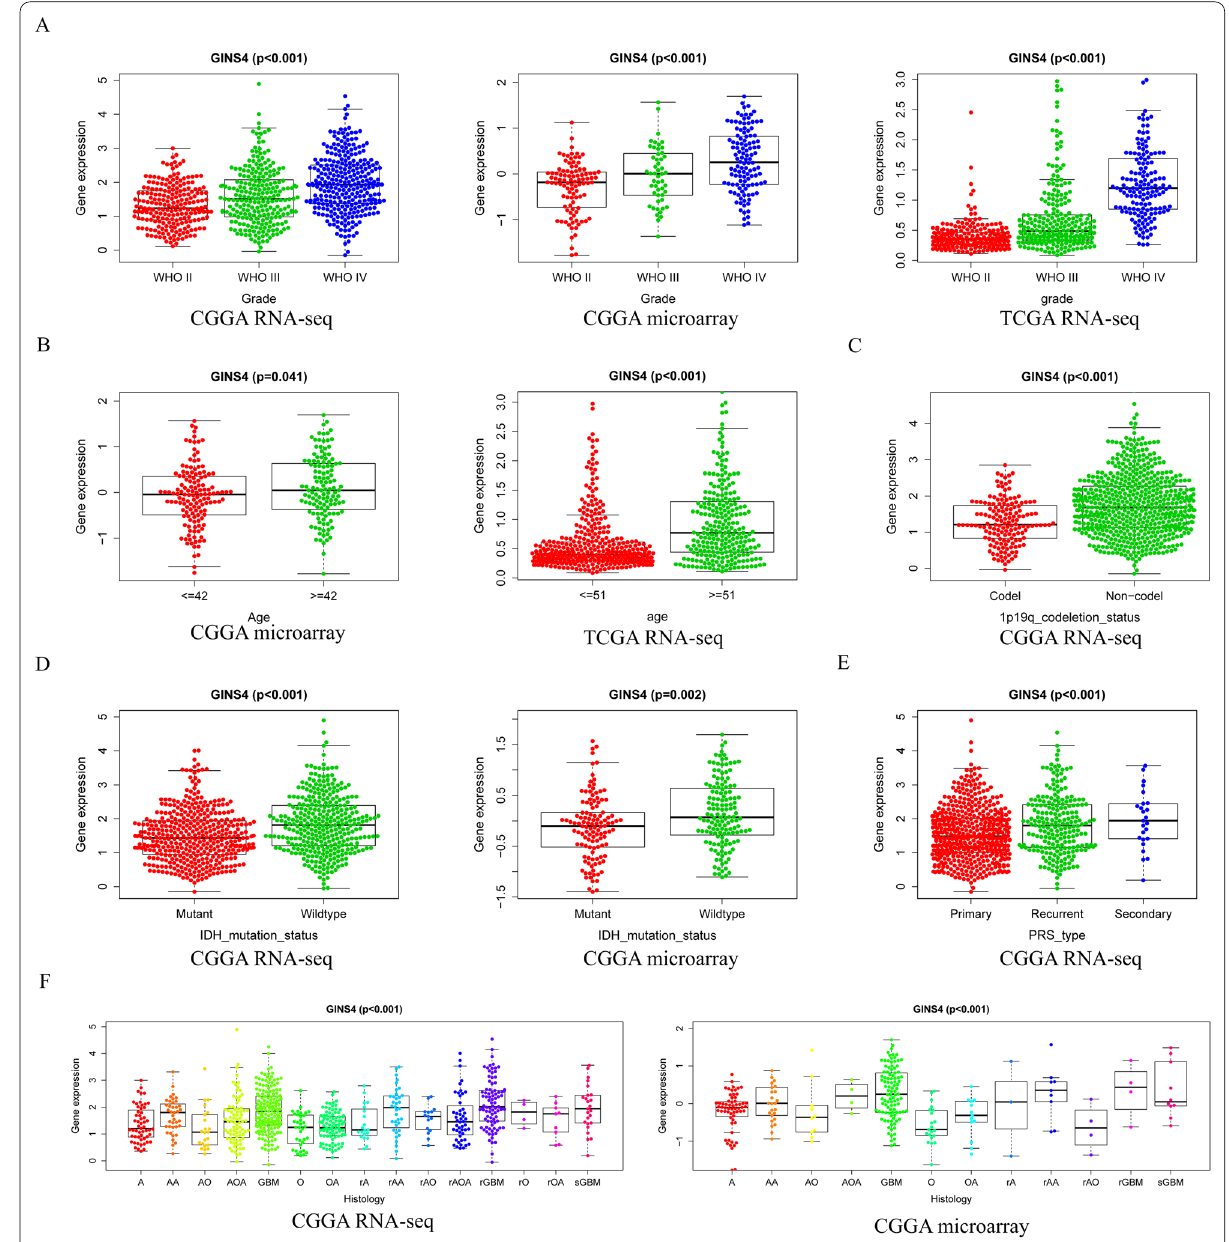
Fig. 3 Relationship between GINS4 expression level and multiple clinical features in the three cohorts of CGGA RNA-seq, CGGA microarray, and TCGA RNA-seq. A The level of GINS4 in different grades of gliomas; B the relevance between the level of GINS4 and the age of glioma patients; C the relationship between the level of GINS4 and 1p/19q codeletion status; D the relationship between the level of GINS4 and IDH_mutation_status; E the levels of GINS4 in primary, recurrent and secondary gliomas. F the level of GINS4 in gliomas of different histological